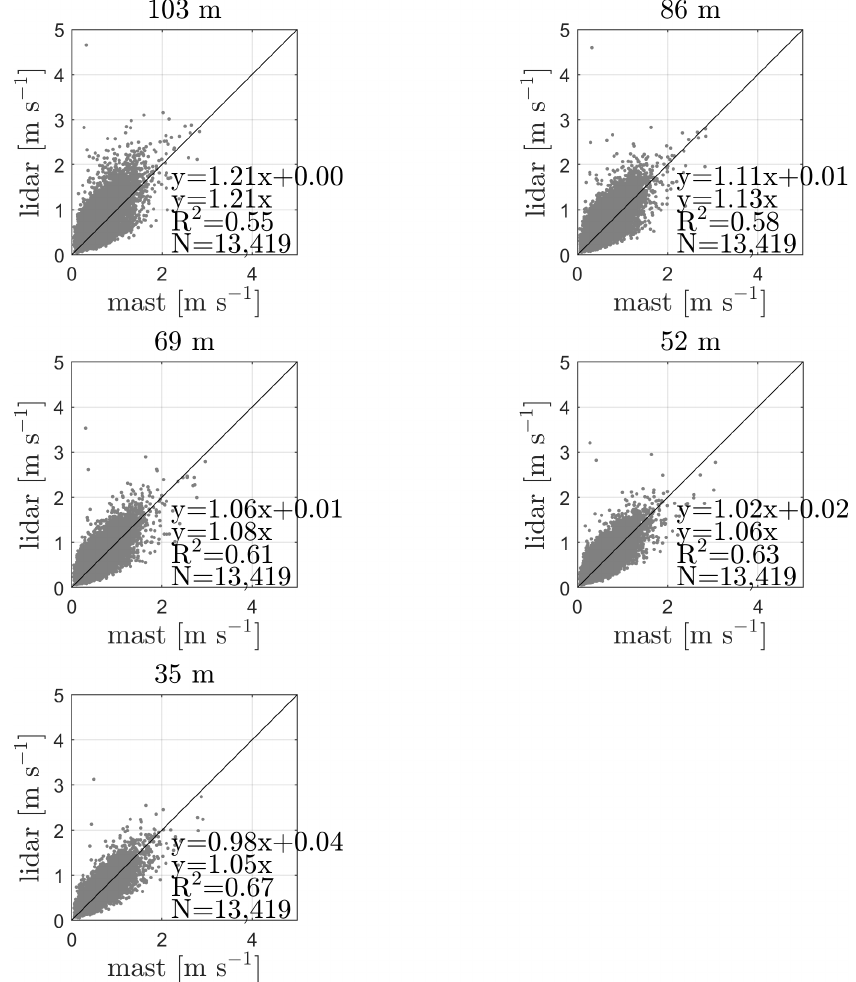
Figure 10. Similar to Figure 8 but for the compensated standard deviation of the horizontal wind speed from the ZX